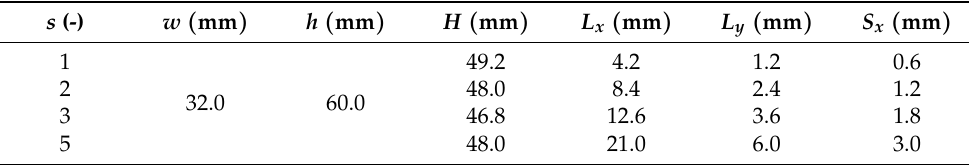
Table 1. The combination of parameters of s , w , h , H , L x , L y , and S x of the design of the Kirigami structure. The definitions of parameters are schematically shown in Figure 1b,c. H is defined as the initial specimen length relevant to the evaluation of strains. s indicates the ratio of the unit size of the Kirigami structure to the standard one in the experiments without the variation in shape. h indicates the whole specimen